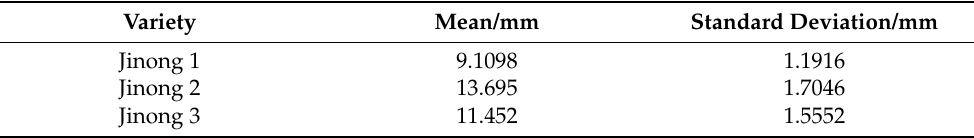
Table 5. The mean and the standard deviation of the width of different varieties of Cyperus esculentus seeds.